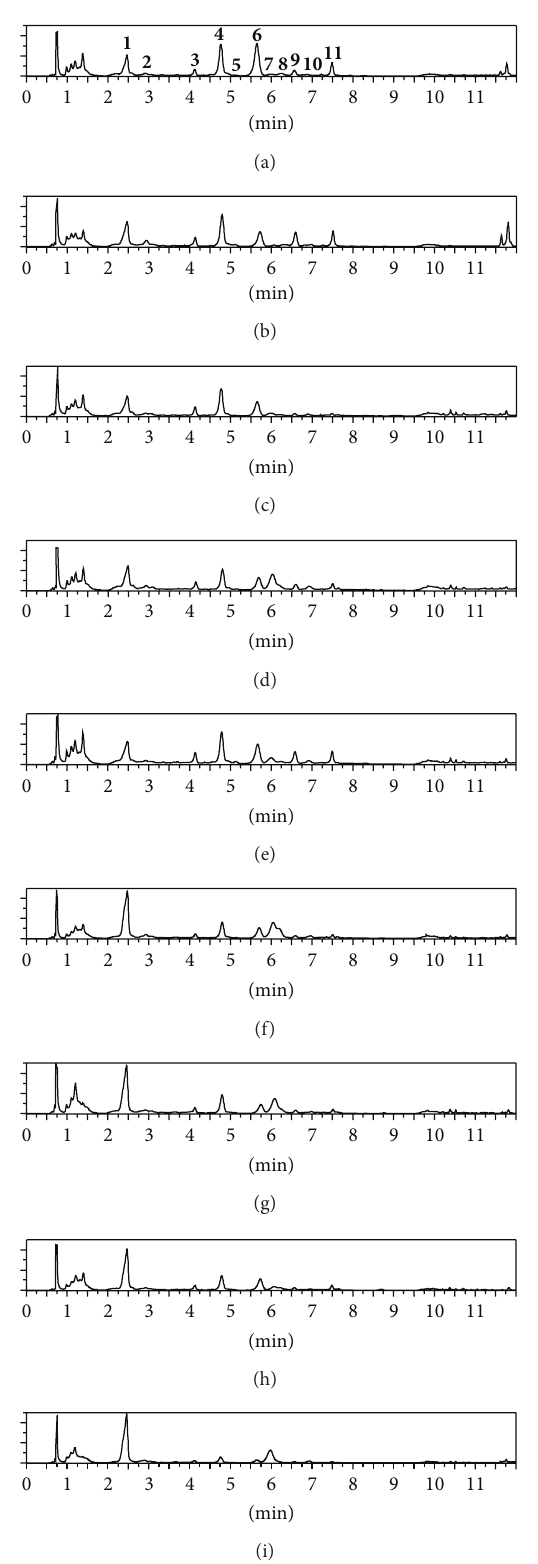
Figure 4: HPLC-UV chromatograms (270nm) of ethanolic extracts from C. officinalis leaves. Varieties: (a)—“Touch of Red,” (b)—“Green Heart Orange,” (c)—“Russian Size,” (d)—“Indian Prince,” (e)—“Red Black Centered,” (f)—“Radio,” (g)—“Egypt Sun,” (h)—“Geisha,” (i)— “Flame Dance.” Compounds: 1 —3- O -caffeoylquinic acid, 2 —caffeic acid, 3 —thyphaneoside, 4 —isoquercitrin, 5 —rutin, 6 —quercetin-3- O - (6 󸀠󸀠 -acetyl)- 𝛽 -d-glycoside, 7 —3,5-di- O -caffeoylquinic acid, 8 —1,5-di- O -caffeoylquinic acid, 9 —isorhamnetin-3- O - 𝛽 -d-glucoside, 10 —4,5- di- O -caffeoylquinic acid, and 11 —isorhamnetin-3- O -(6 󸀠󸀠 -acetyl)- 𝛽